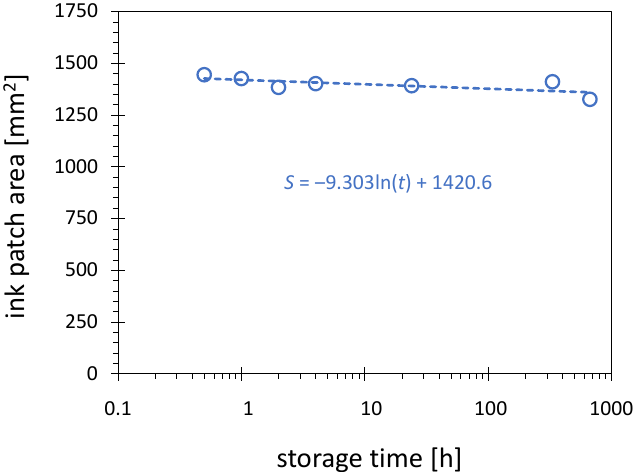
Figure 9. Influence of the storage time on the activation area. The 10 s plasma treatment of the HDPE substrates was conducted with nitrogen flow of 8.0 SLM, PCPG input power of 8.0 W, and visualized with the 58 mN/m test